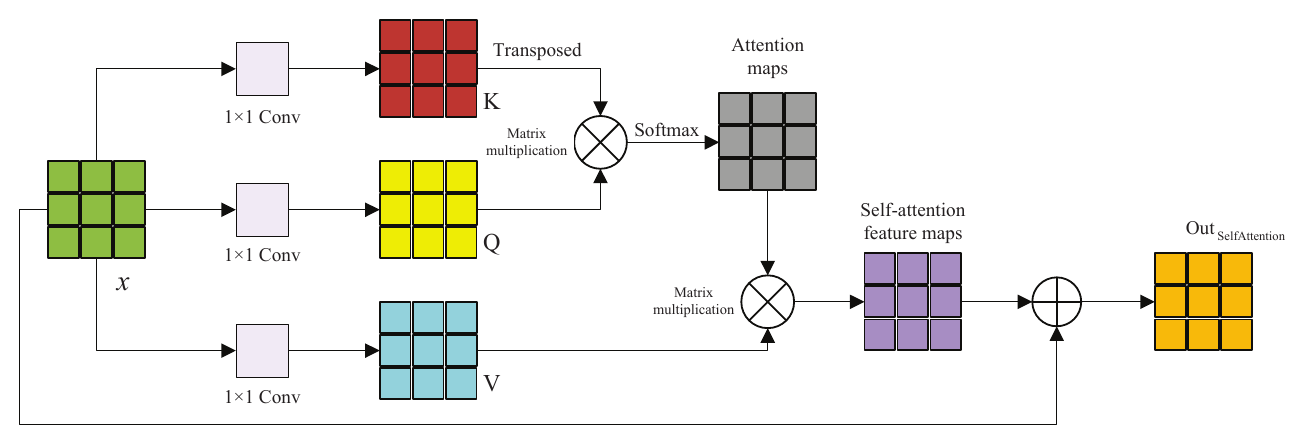
Figure 3. The data processing flow of the self-attention